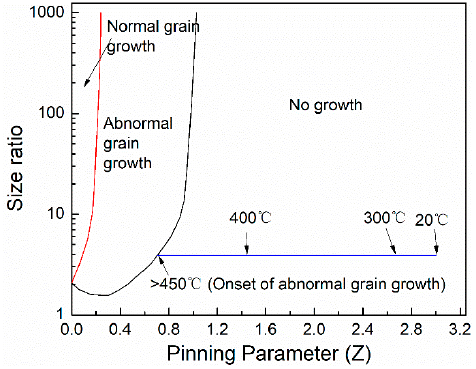
Figure 1. A microstructural stability map demonstrating the transition of microstructure from no growth to abnormal grain growth, reproduced from [65], with permission from Elsevier, 2002.